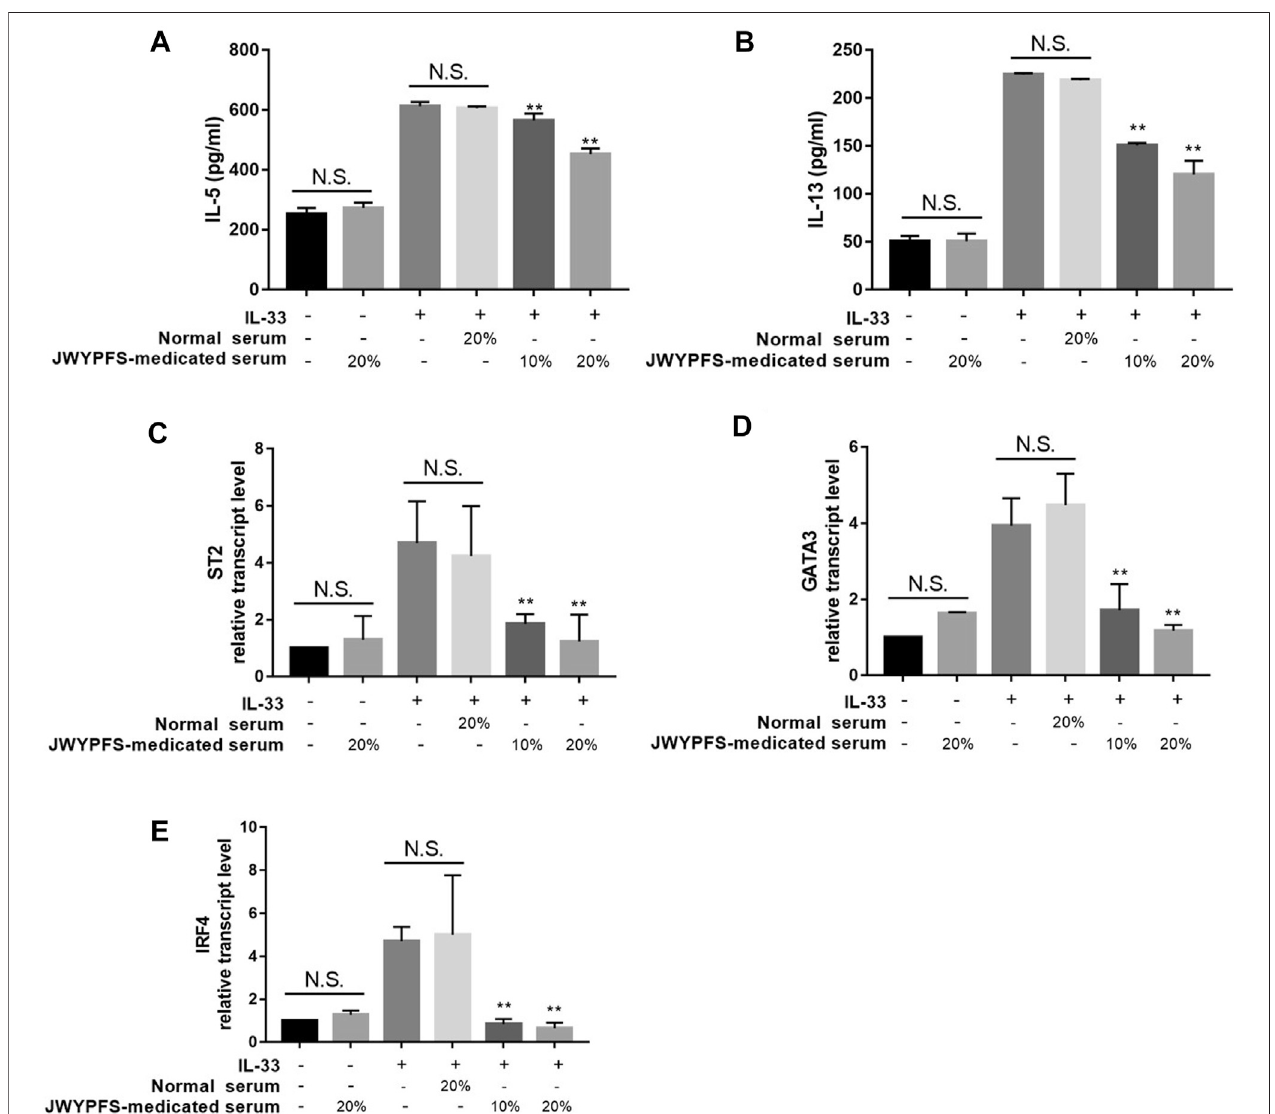
FIGURE7| Theeffect ofJWYPFS ontype 2cytokines and transcription factor expression inIL-33-stimulated ILC2s invitro . (A) IL-5inculture medium. (B) IL-13 in culture medium. (C) ST2 mRNA expression of ILC2s. (D) GATA3 mRNA expression. (E) IRF4 mRNA expression in ILC2s. Data are shown as mean ± SD. N.S. for not signi fi cant, * p < 0.05, ** p < 0.01, compared with the IL-33 combined normal serum treatment group.